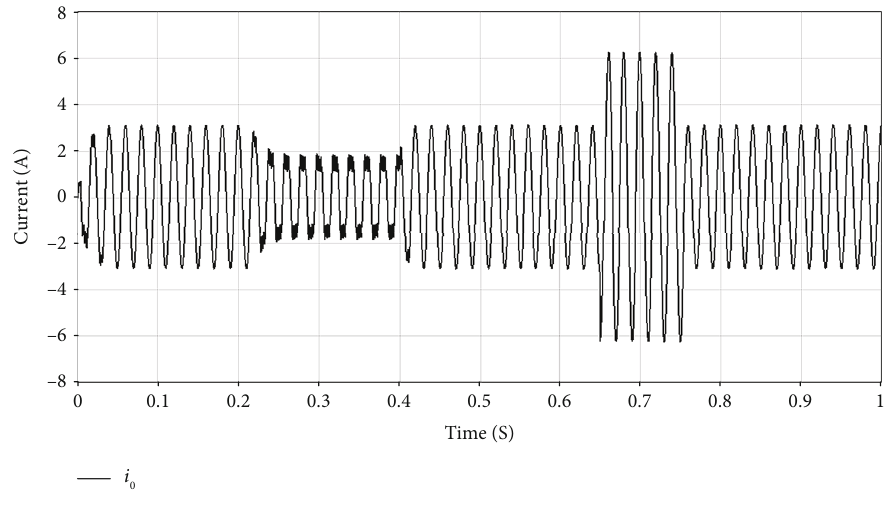
Figure 20: Current consumed by the loads.